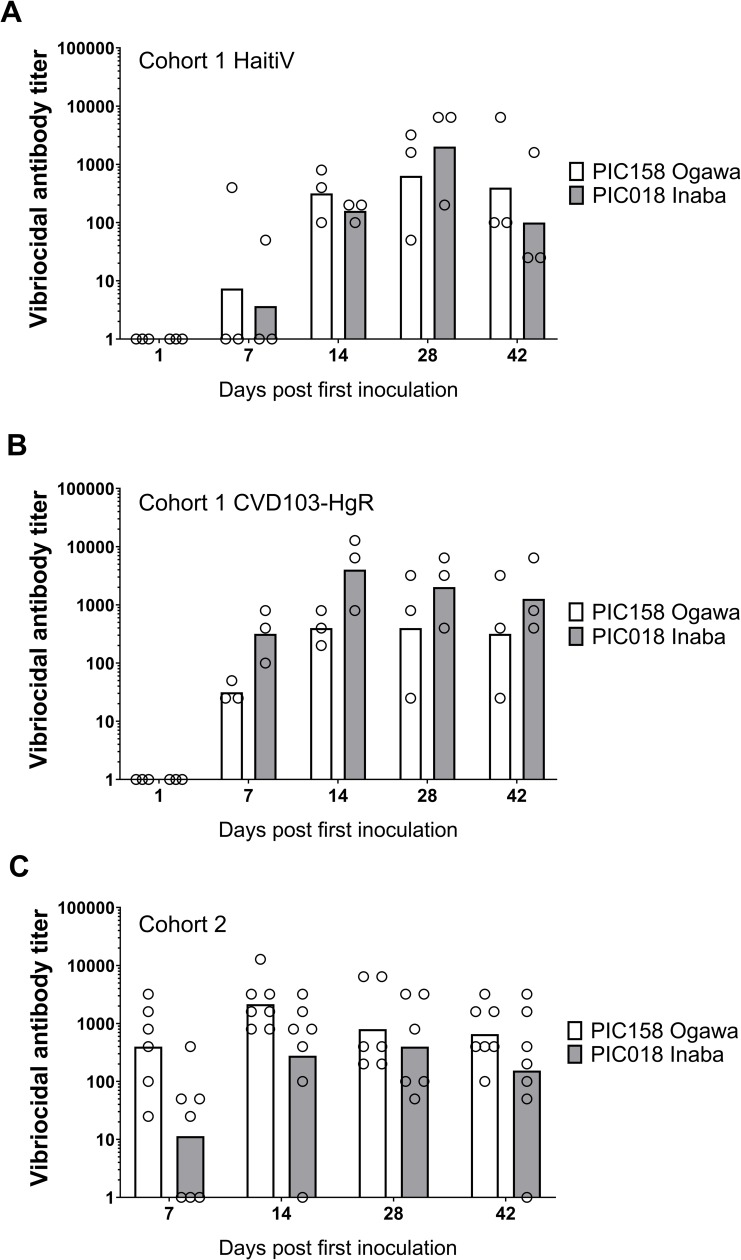
Vibriocidal titers in immunized mice.Vibriocidal titers measured in cohort 1 mice immunized with (A): HaitiV or (B): CVD103-HgR, and in (C): cohort 2 mice immunized with HaitiV are shown. Each circle corresponds to the lowest dilution at which vibriocidal activity was observed and the height of the bars represent geometric mean titers in each group. Ogawa-specific responses, measured using strain PIC158, are shown in white and Inaba-specific responses, measured using strain PIC018, are shown in gray. Serum samples with undetectable vibriocidal activity were assigned a titer of 1.